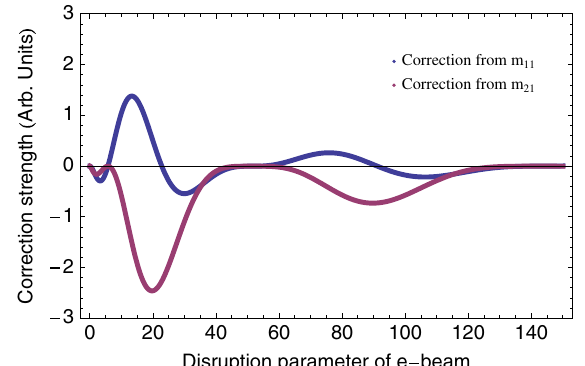
FIG. 7. The expected effectiveness of the proposed feedback system, calculated from the simplified